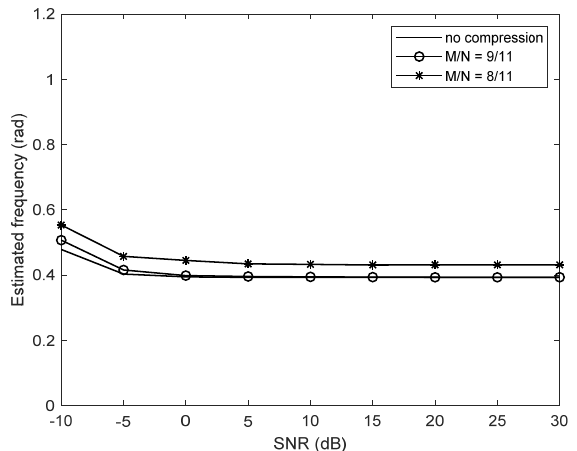
Figure 4. Frequency estimate ( ˆ ω o ) versus SNR, the colored noise case, using CCS with differ- ent compression ratios as well as the estimator without compression [27]. ω o = π α = 5, B = 10, p = 5, q =